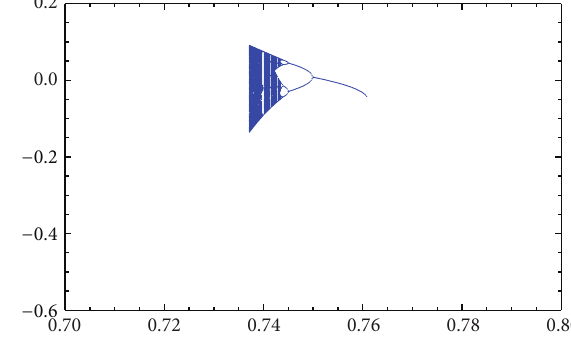
Figure 18: Feigembaun diagram for 𝜆 = 0.8 .